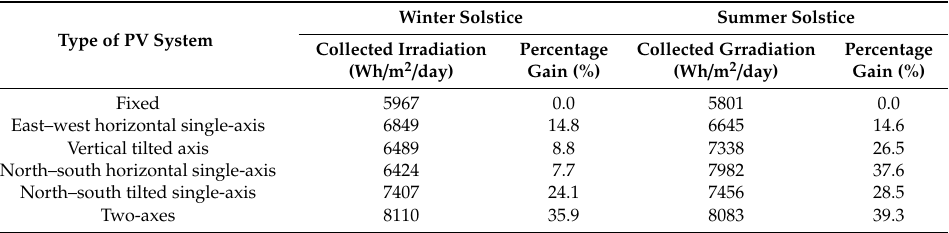
Table 1. Daily collected irradiation and percentage gains relative to a south-oriented fixed structure system with tilt equal to latitude of the di ff erent types of sun trackers for the winter and summer solstices in